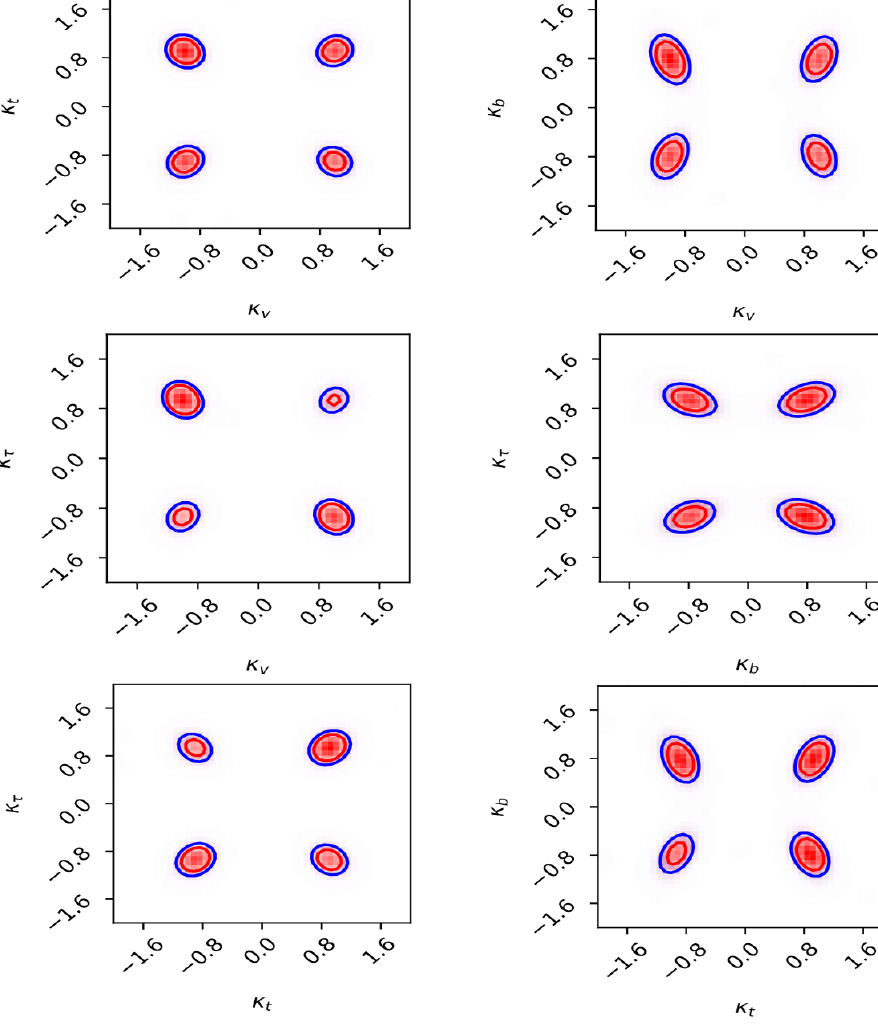
Figure 2 . Allowed regions at 1 (cid:27) (red) and 2 (cid:27) (blue) levels in the parameter space of scale factors.